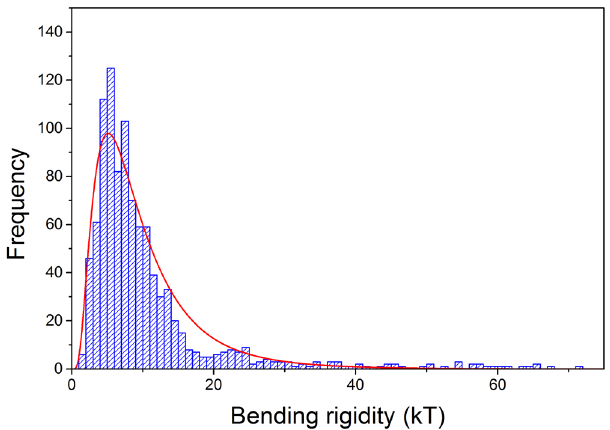
Figure 3. A histogram of the membrane bending rigidities ( κ mem ) of a tubule in the endoplasmic reticulum calculated using Eq. (3) measured using STORM images of anti-KLC3. A lognormal distribution was fitted to the data. The average membrane bending rigidity of the ER tubules was 10.9 ± 1.2